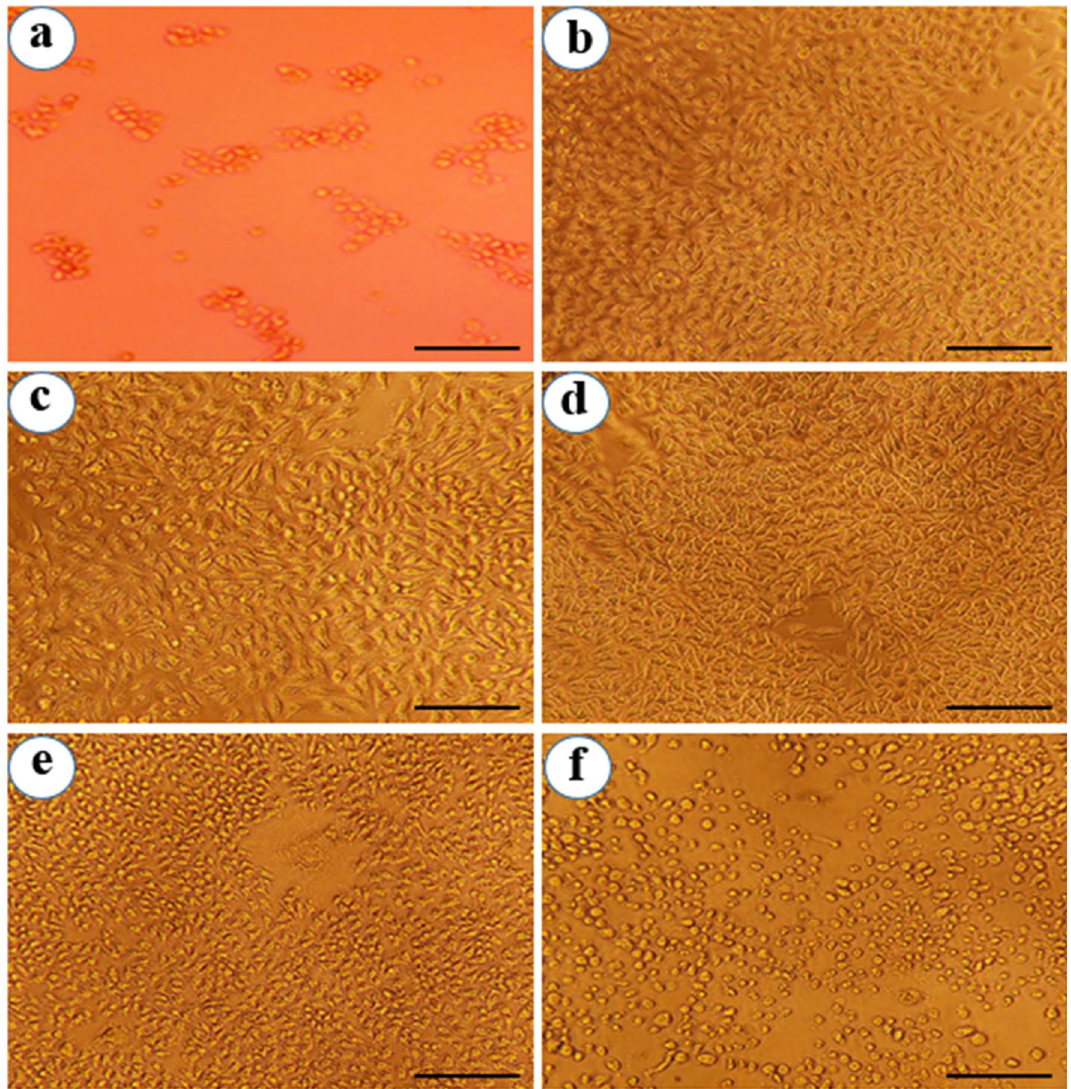
Figure 9. Cytotoxic activity of the different concentrations of Pf-AgNPs on MCF-7 cells. ( a ) Standard (75 µg/ mL), ( b ) 37.5 µg/mL, ( c ) 75 µg/mL, ( d ) 150 µg/mL, ( e ) 300 µg/mL, ( f ) 600 µg/mL of Pf-AgNPs. (Scale bars represent 200